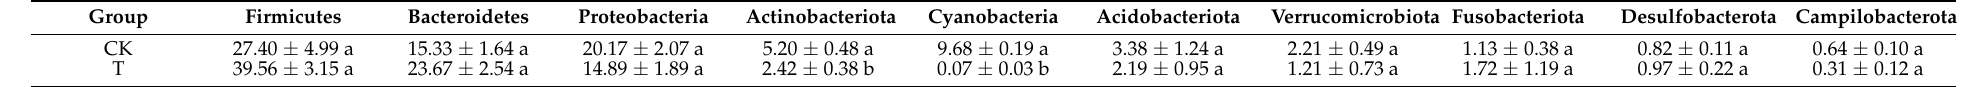
Table 4. Changes in the relative abundance of top 10 phyla in Grapholita molesta gut microbiota samples before and after ciprofloxacin